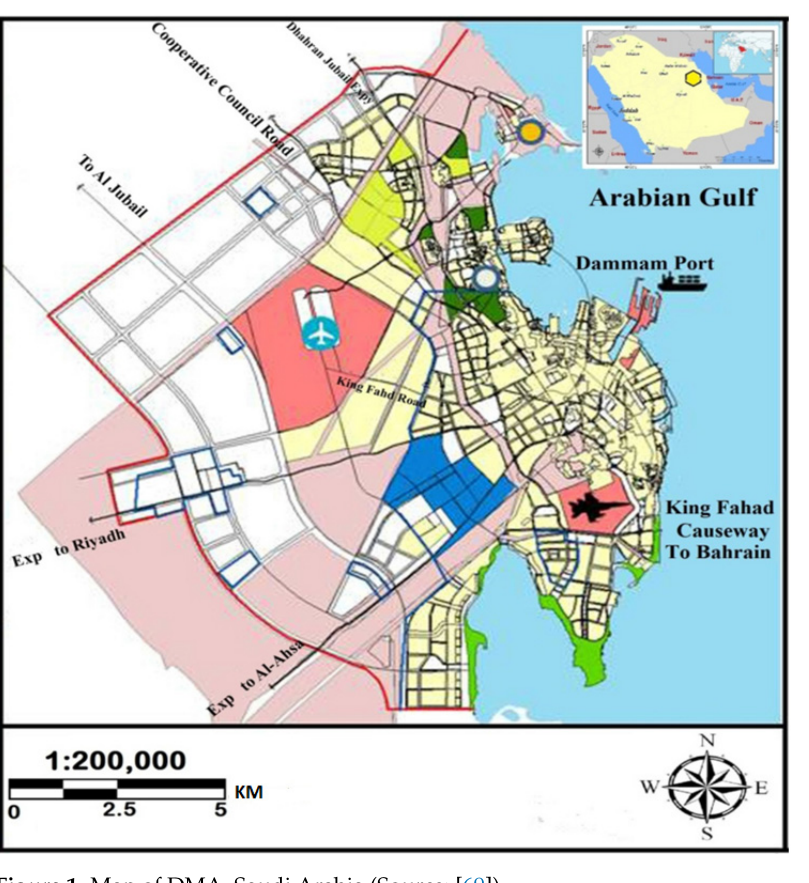
Figure 1. Map of DMA, Saudi Arabia (Source: [69]).